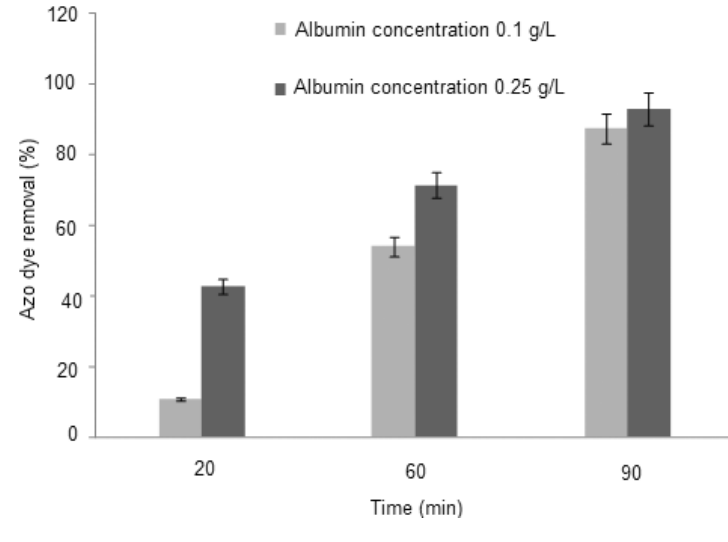
Figure 3. Efficiency of removing azo dye Orange II using albumin in different concentrations (0.10 and 0.25 g/L, v/v) in pH 3.0 and incubation